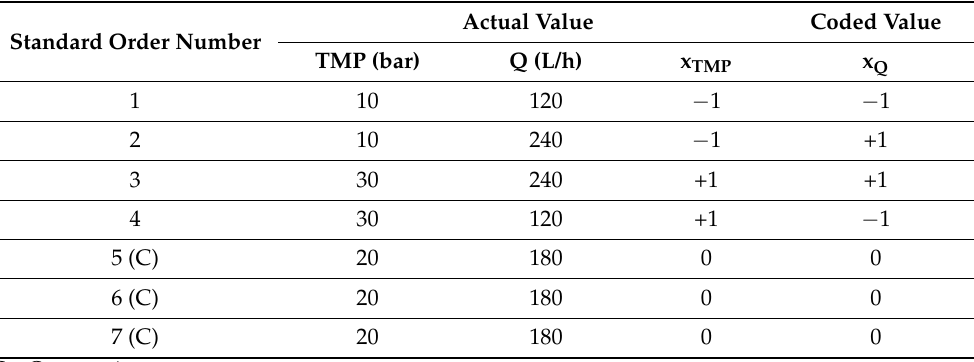
Table 3. The design matrix of the 2 p full factorial experimental design of BDA via RO